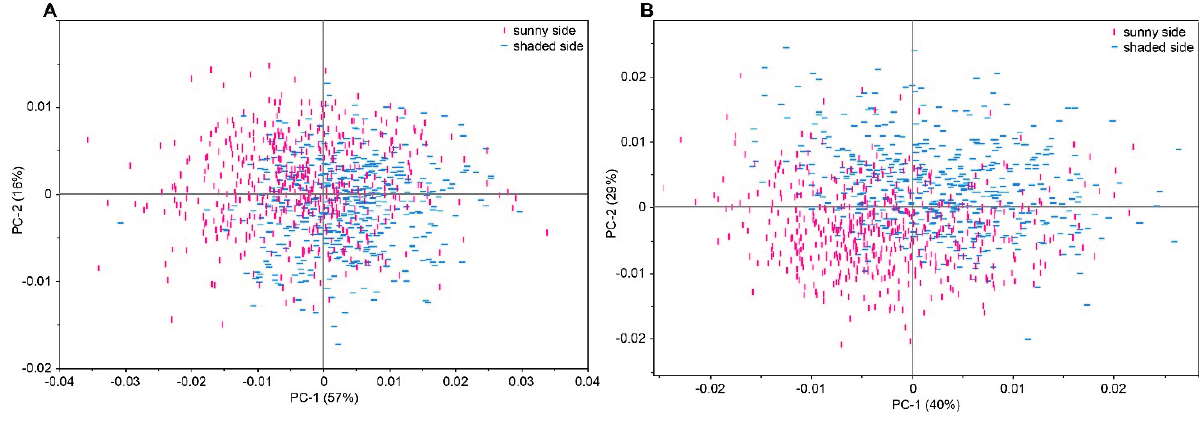
Figure 3. PCA plot of all apple NIR spectral data acquired from the sunny and shaded side of the apples ( A ) 511 “Braeburn” apples on both sunny and shaded side ( B ) 539 “Cripps Pink” for the sunny side and 533 apples for the shaded